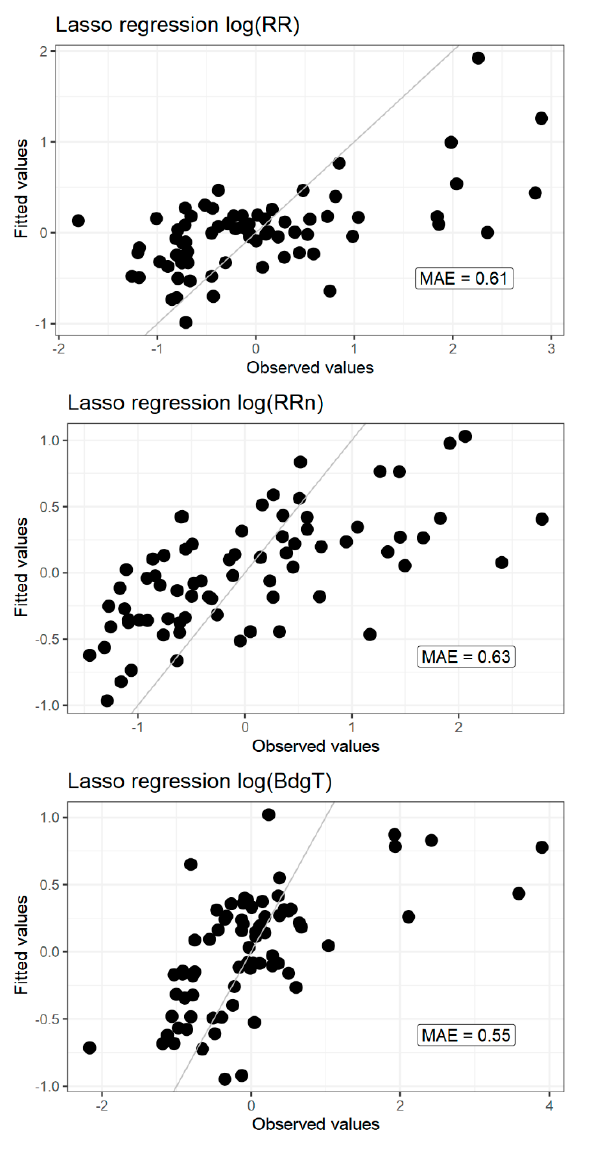
Figure 6. Predicted vs. observed values for lasso regression and multiple linear